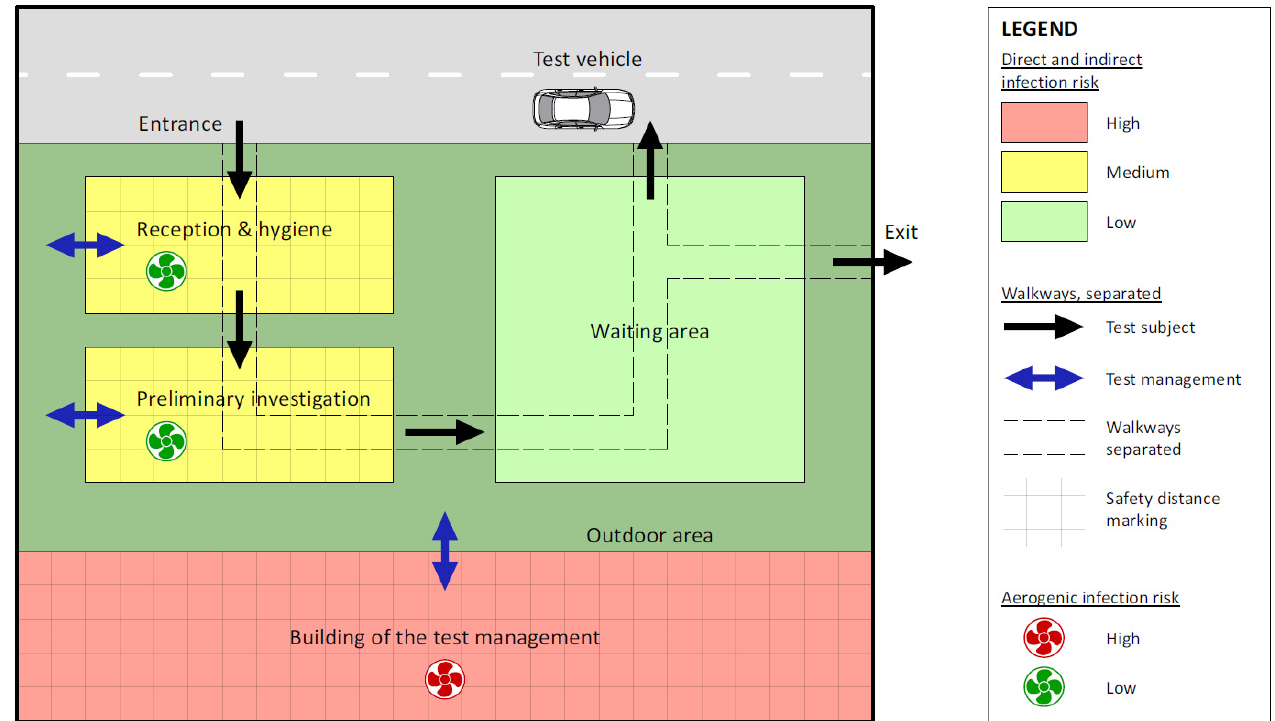
Figure 6. O utdoor area plan for conducting a study using a vehicle. Figure 6. Outdoor area plan for conducting a study using a